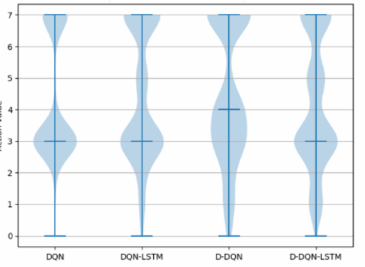
Figure 11. Policy distribution of four DRL algorithms (DQN, DQN-LSTM, D-DQN, and D-DQN- LSTM) in a static environment.